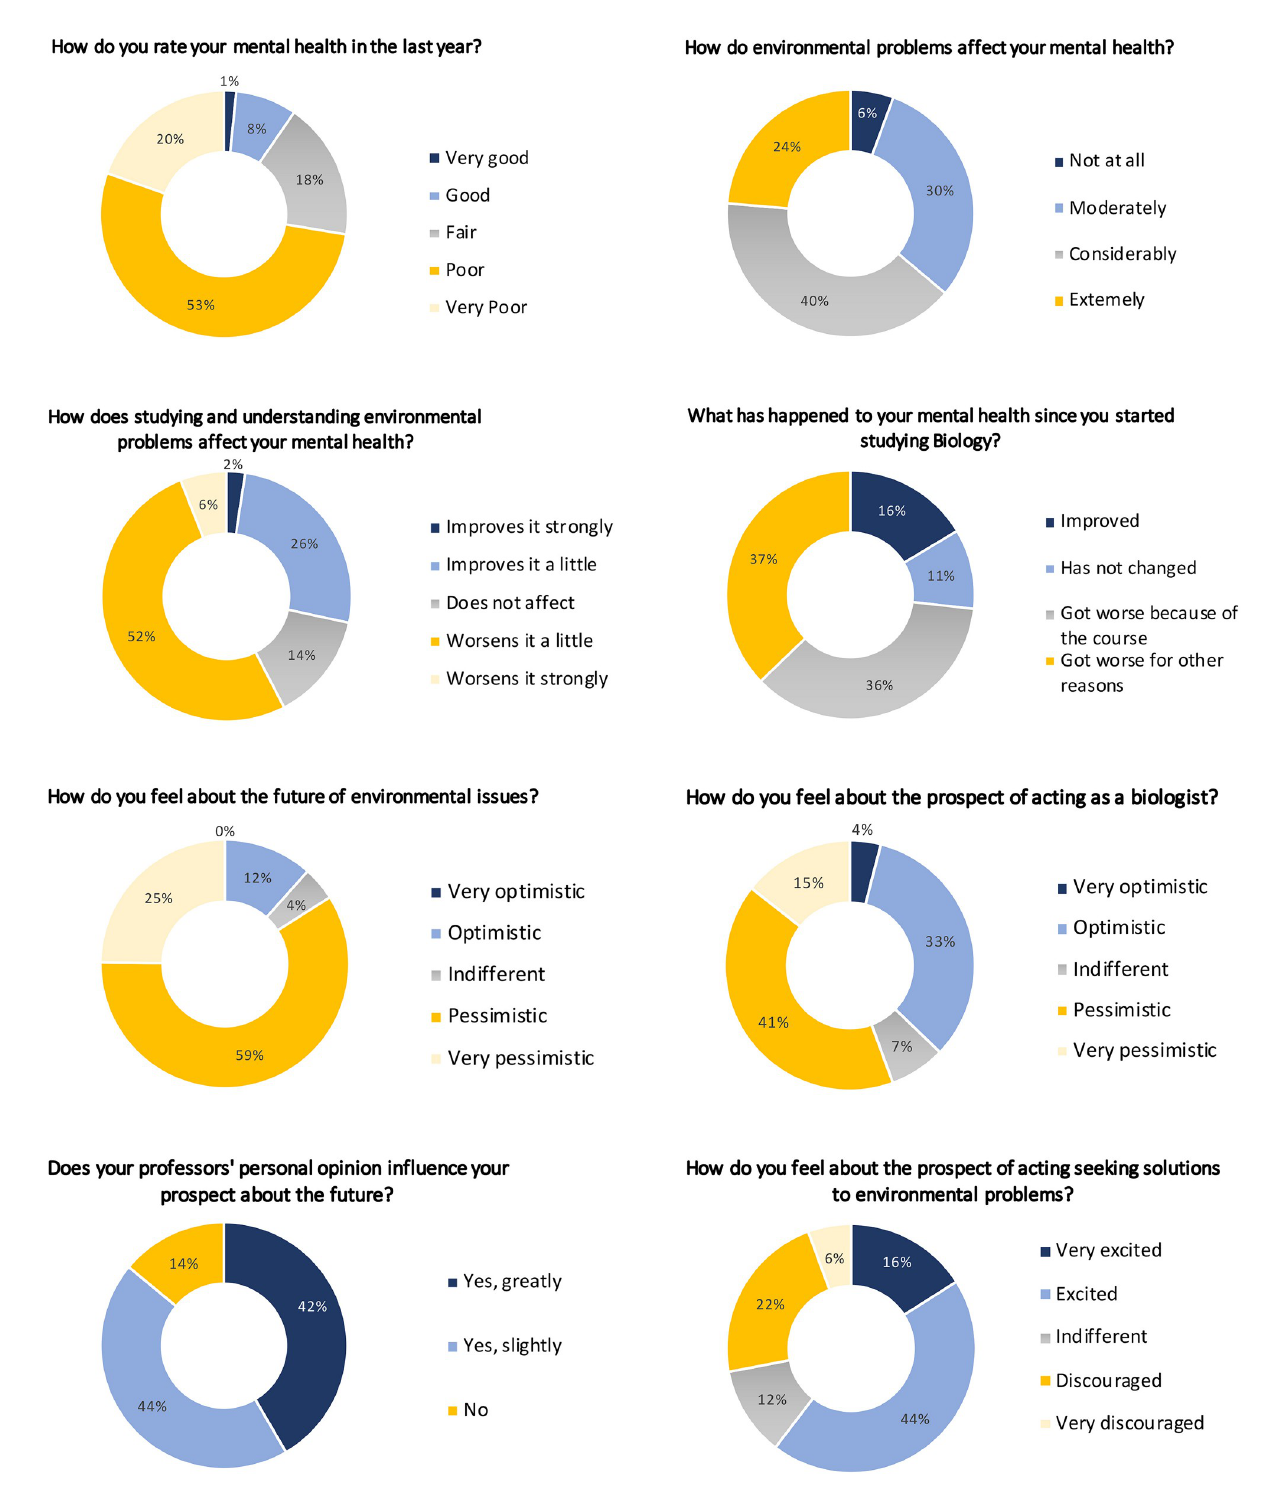
Fig 1. Results of a mental health questionnaire given to 250 biology undergraduate students in Brazil. Charts show the proportions of answers to questions about mental health given by 250 undergraduate students of biological sciences from 6 Brazilian public universities (UFSC, UFSCar, UFPE, UFJF, UFPI, and UENF) in March